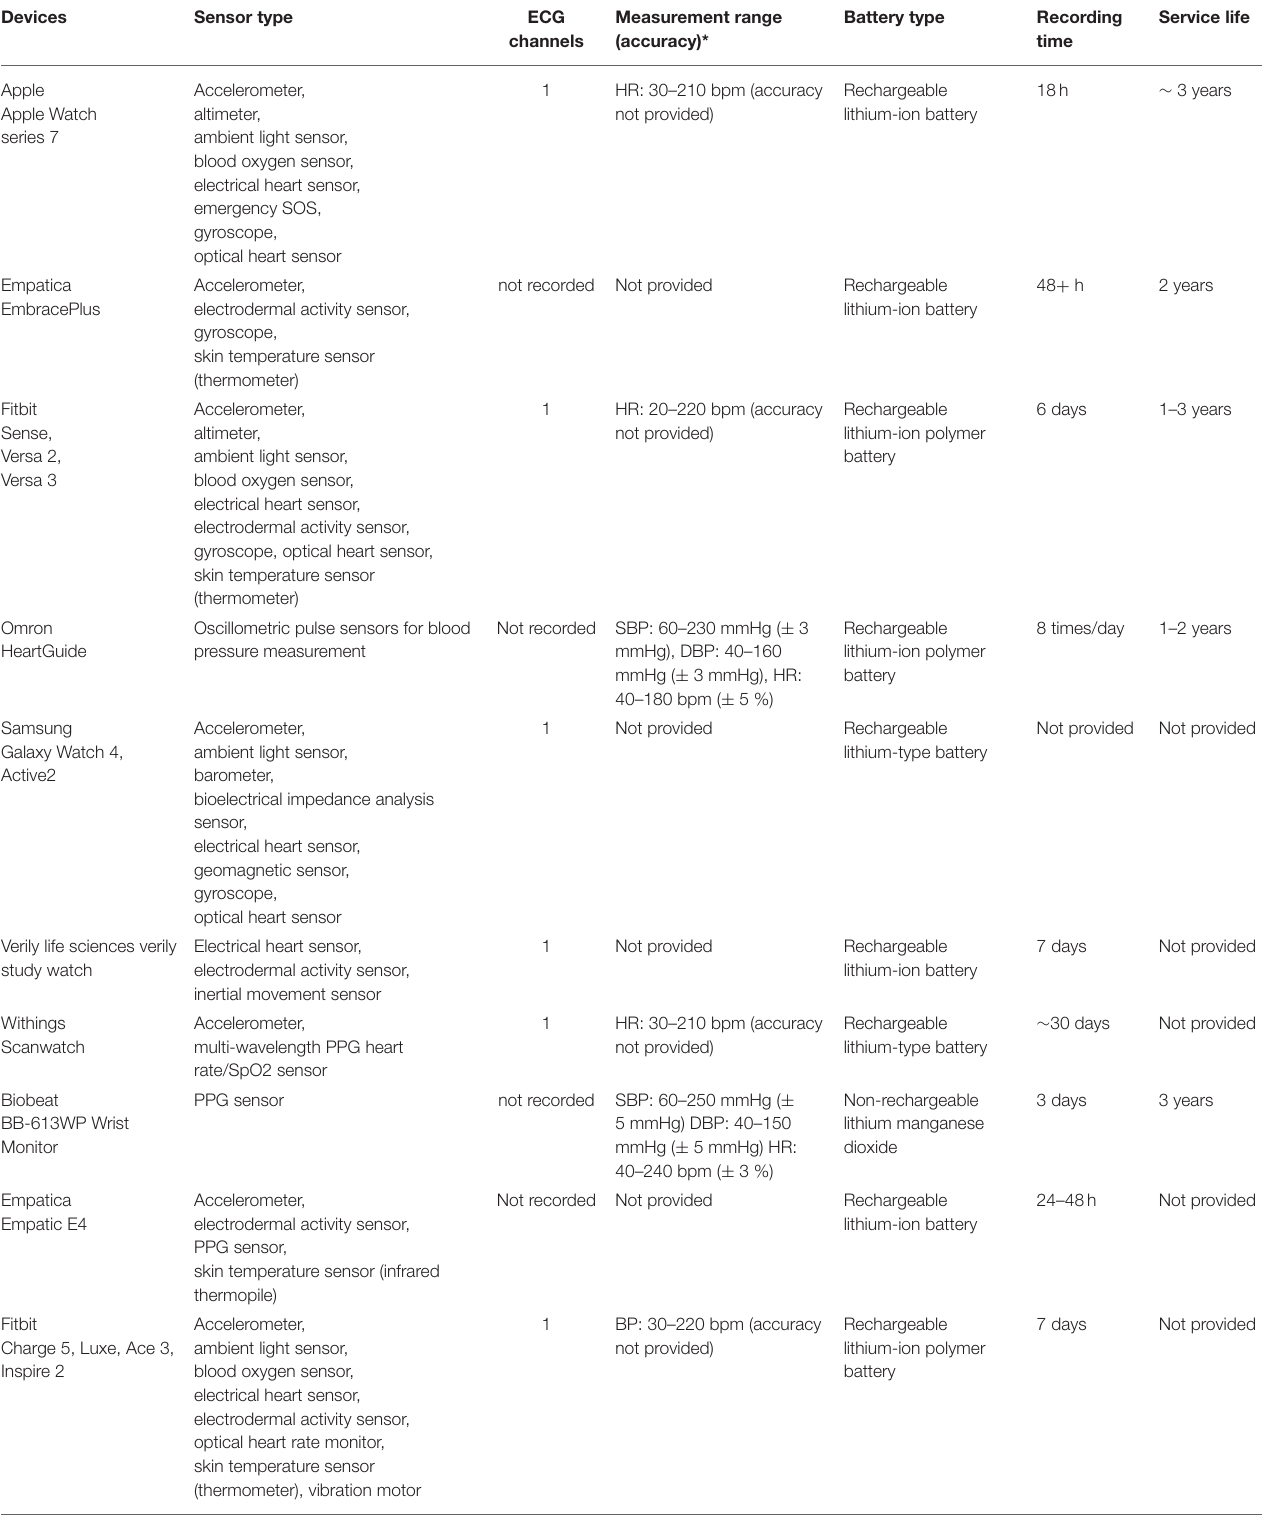
TABLE 2 | Main technical specifications of the smart wearable devices listed in Table 1 . Presented information is derived either from the official website of the respective company, or from the user guide document, detected through the search engine UserManual.wiki.